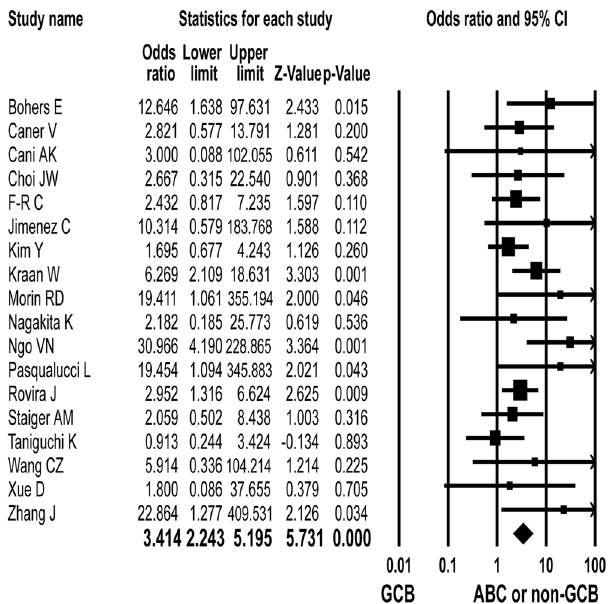
Figure 2. Pooled estimates of the association between MYD88 L265P mutation and activated B-cell-like (ABC) or non-germinal center B-cell-like (non-GCB) subtype of diffuse large B-cell lymphoma. The forest plot demonstrates each study and overall effect sizes and 95%